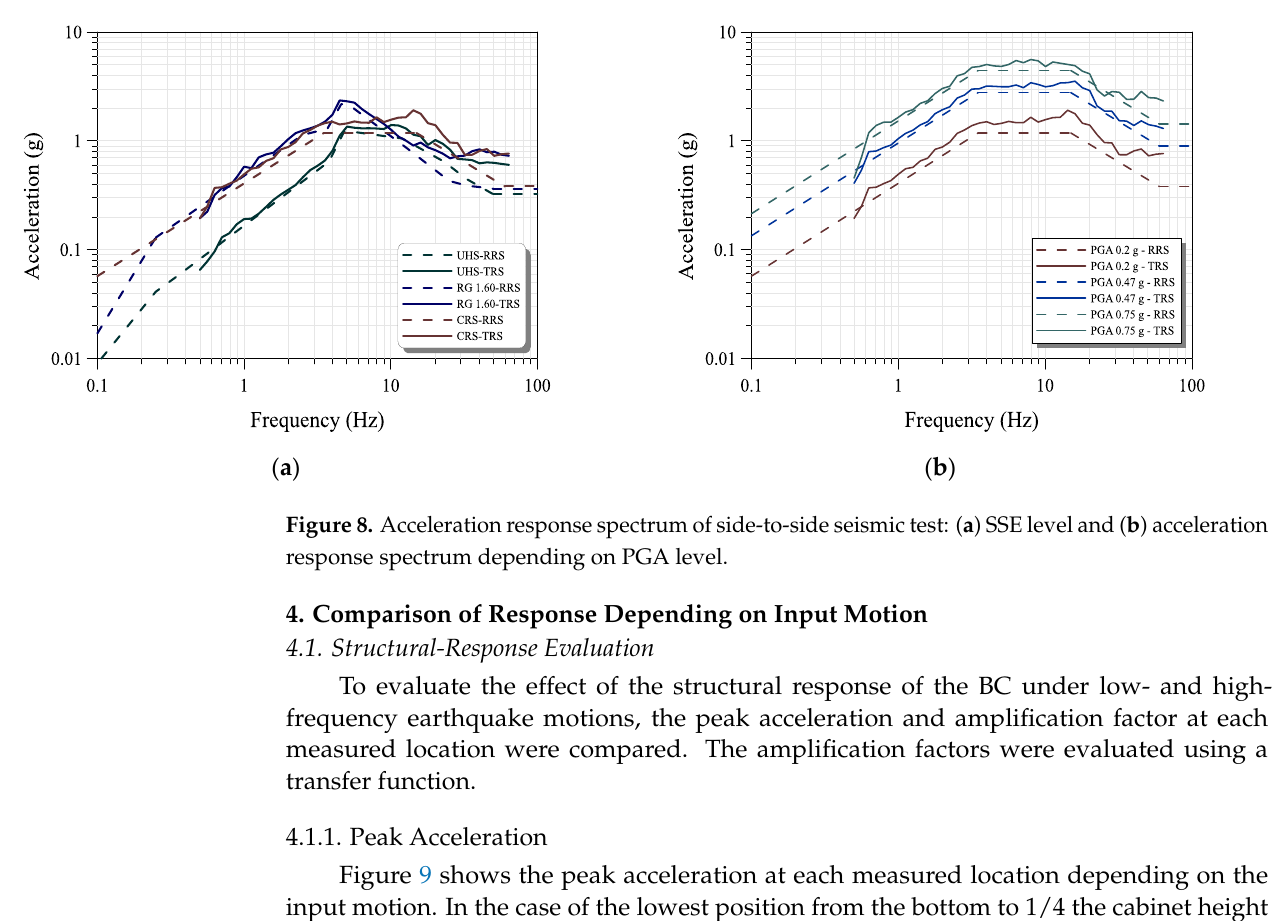
Figure 7. In-cabinet resonant-frequency test results: ( a ) side to side, ( b ) front to back, and ( c ) verti- cal.